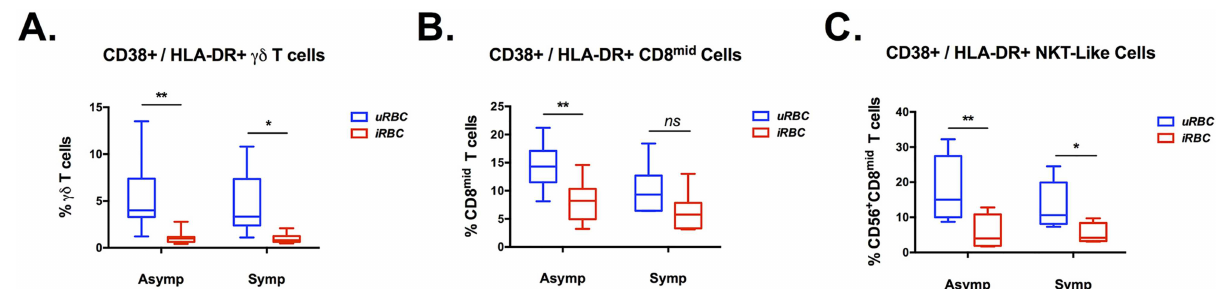
Fig 5. Analysis of CD38 + /HLA-DR + activation status of T cell sub-populations in asymptomatic and symptomatic malaria patients. Co-expression of CD38and HLA-DR on T cells has been suggestedas a marker of activationfor malaria reactive T cells. The expressionof these surface markers was analyzedin T cell subpopulations from asymptomatic (n = 9) and symptomatic (n = 6) patient PBMCs during exposure to P . falciparum strain H1064 infected erythrocytes(iRBC lysate) or uninfectederythrocytes (uRBC). Exposureto P . falciparum antigens diminished the activationstatus of γδ T cells (A) , CD mid T cells (B) , and NKT-like T cells (C) . Statistical significancewas determined using a two-tailedWilcoxon matched-pairs signed rank test (iRBC lysate vs. uRBC for each patient). * = p-value < 0.05, ** = p-value < 0.01.